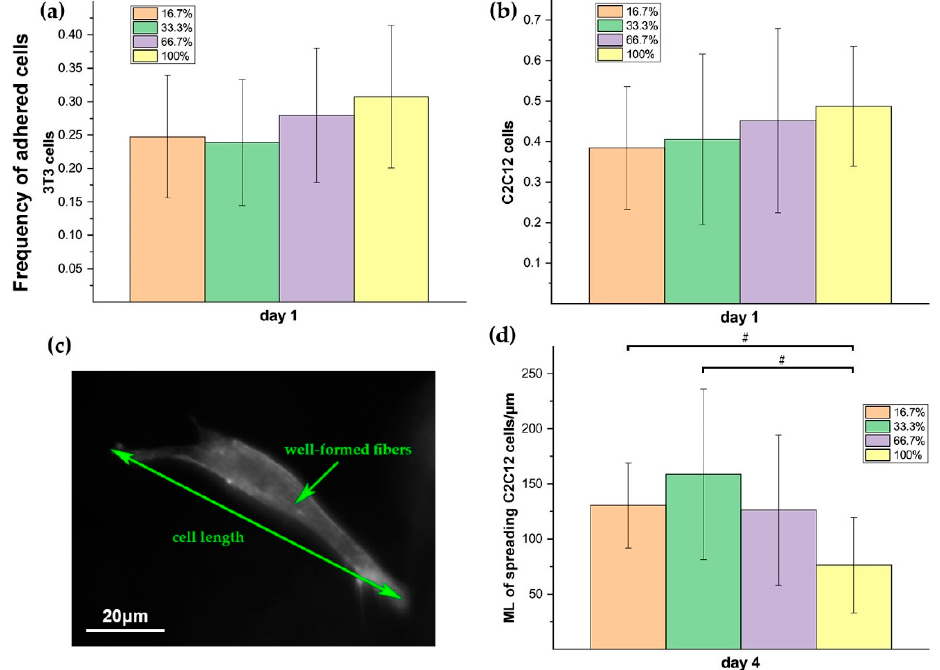
Figure 9. The impact of the composition configuration of 3D dextran hydrogels with clustered and homogenous RGD distribution on initial cell adhesion. The main parameters of dextran hydrogel were a crosslinking strength = 2 mM and RGD = 50 µM. ( a ) Adhesion rates of 3T3 cells on day 1 in groups 1–4; ( b ) Adhesion rates of C2C12 cells on day 1 in groups 1 – 4; ( c ) The well-formed fibers of adhered C2C12 cells were stained by phalloidin. ( d ) The maximum length (ML) of spreading C2C12 cells was measured on day 4 in groups 1–4. The measurement was conducted by ImageJ software. The data were presented by mean ± SD; # p < 0.01 versus the corresponding 3D homogenous samples.